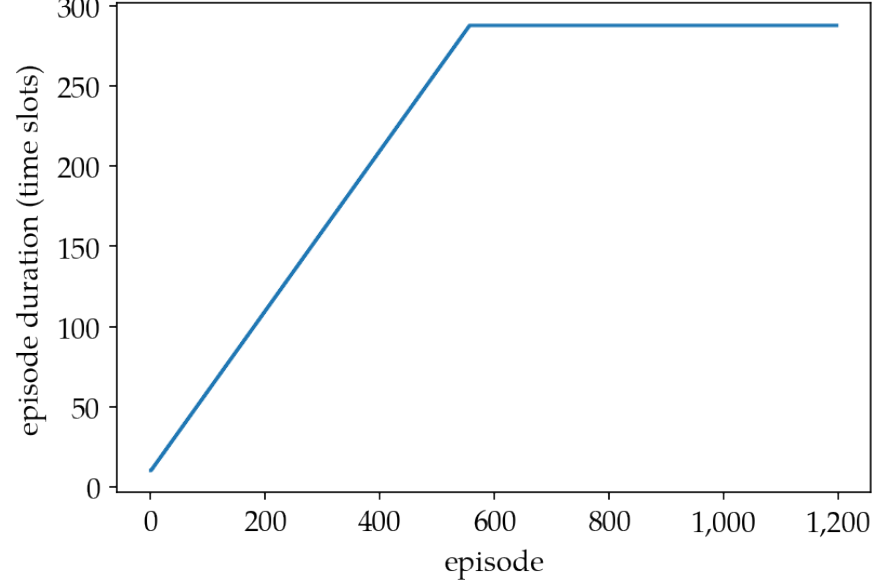
Figure 8. Plot of incremental episode duration during